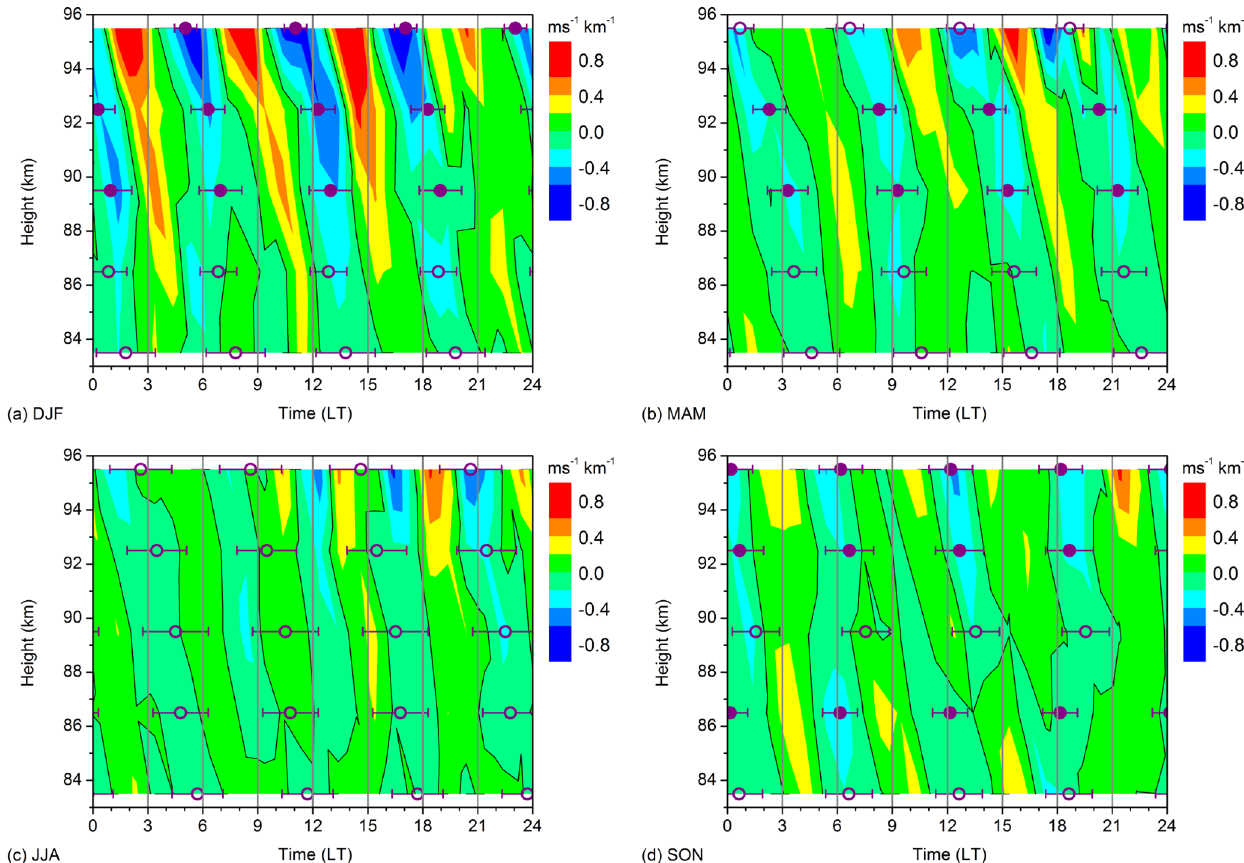
Figure 3. 2007–2016 mean seasonal mean Collm residual wind shear after removing diurnal mean shear, 8, 12, and 24h components for (a) DJF, (b) MAM, (c) JJA, and (d) SON. The 6h phases, defined as the time of maximum negative wind shear, are added together with their standard deviation calculated from phases of single years. Solid symbols denote oscillations significant at the 5% level according to a t